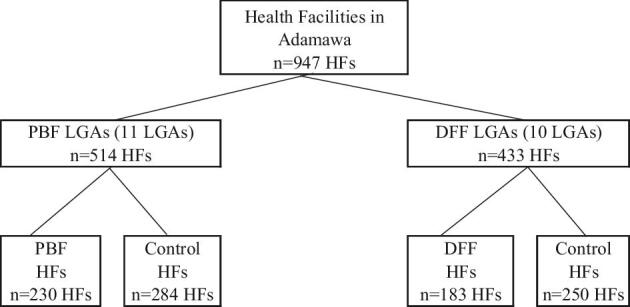
Distribution of HFs by treatment status.